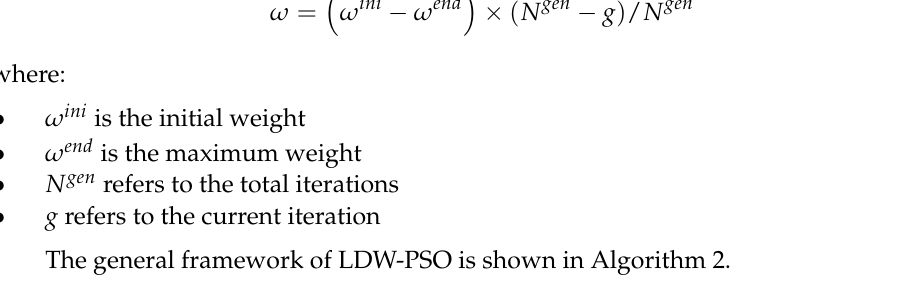
Algorithm 2. LDW-PSO—Particle Swarm Optimization with Linearly Decreasing